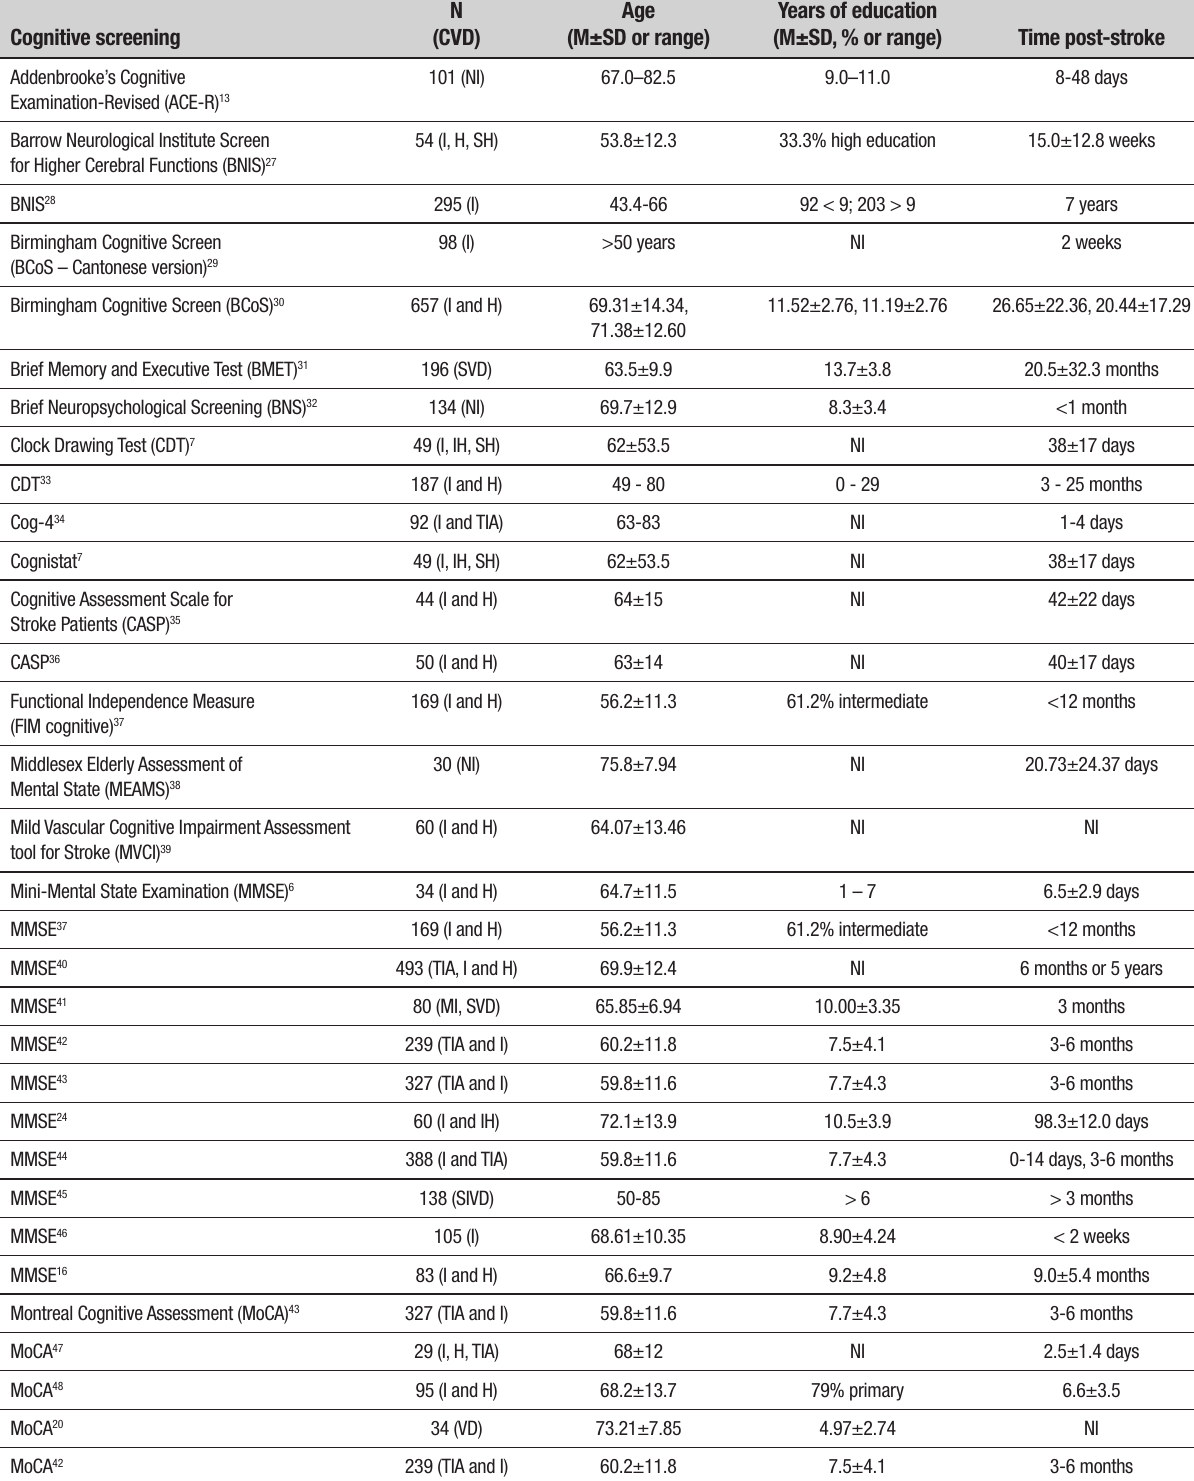
Table 1. Cognitive screening and characteristics of the